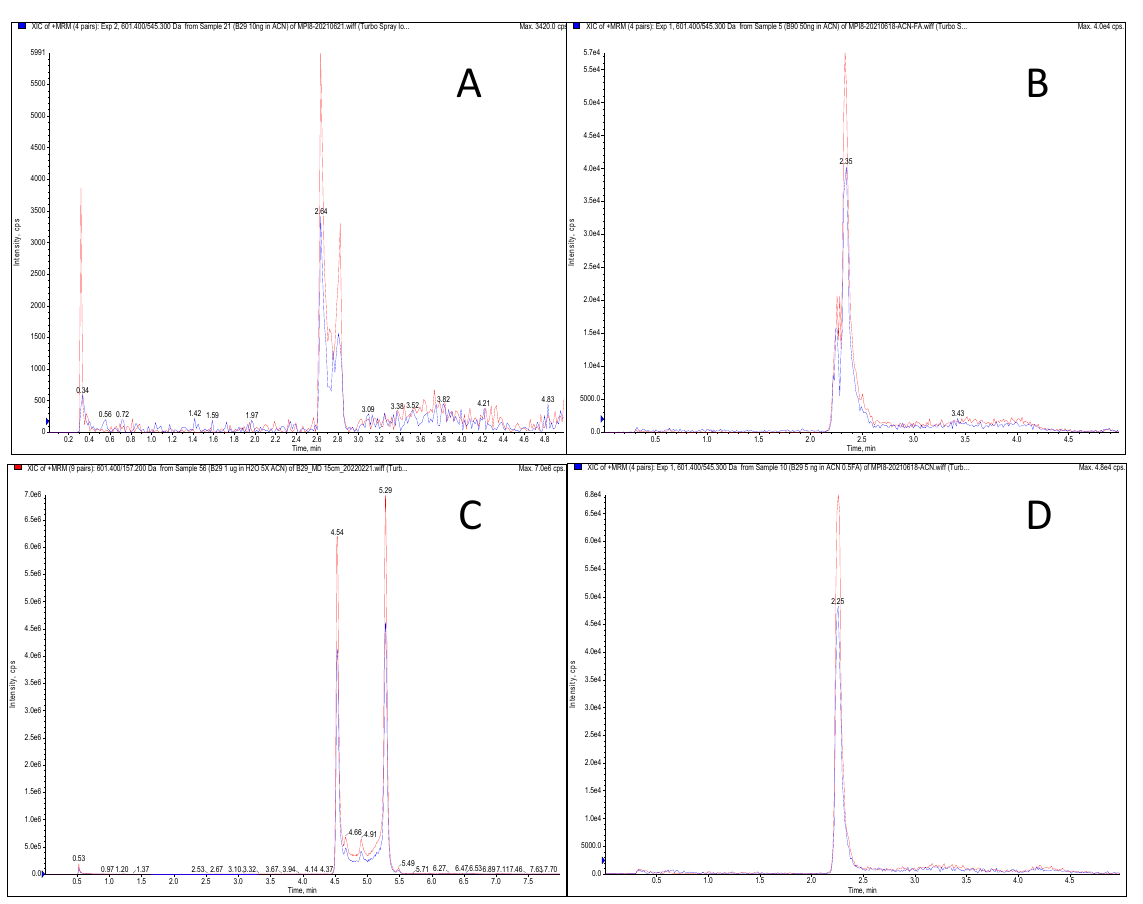
Figure 2. MRM chromatograms for MPI8 (transitions m/z 601.4 → 545.3 and 601.4 → 157.2): Not-fully- separated multiple peaks on a Kinetex F5 column ( A ) and an Acquity HSS-T3 column ( B ); distinctly separated double peak chromatograms of MPI8 on a Synergi Fusion-RP column ( C ); single peak with good peak shape on a Kinetex HILIC column ( D ). The time program of the gradient: ( A , B , D ) Phase B was initially kept at 5% for 0.5 min, increased from 5% to 90% in the next 2.5 min, then decreased to 5% in 1.0 min, and kept stably at 5% for 1 min; ( C ) Phase B was initially at 20% for 0.5 min, increased from 20% to 90% in 4.5 min, kept at 90% for 2 min, decreased to initial concentration (20%) in 1 min and equilibrated for 2 min.